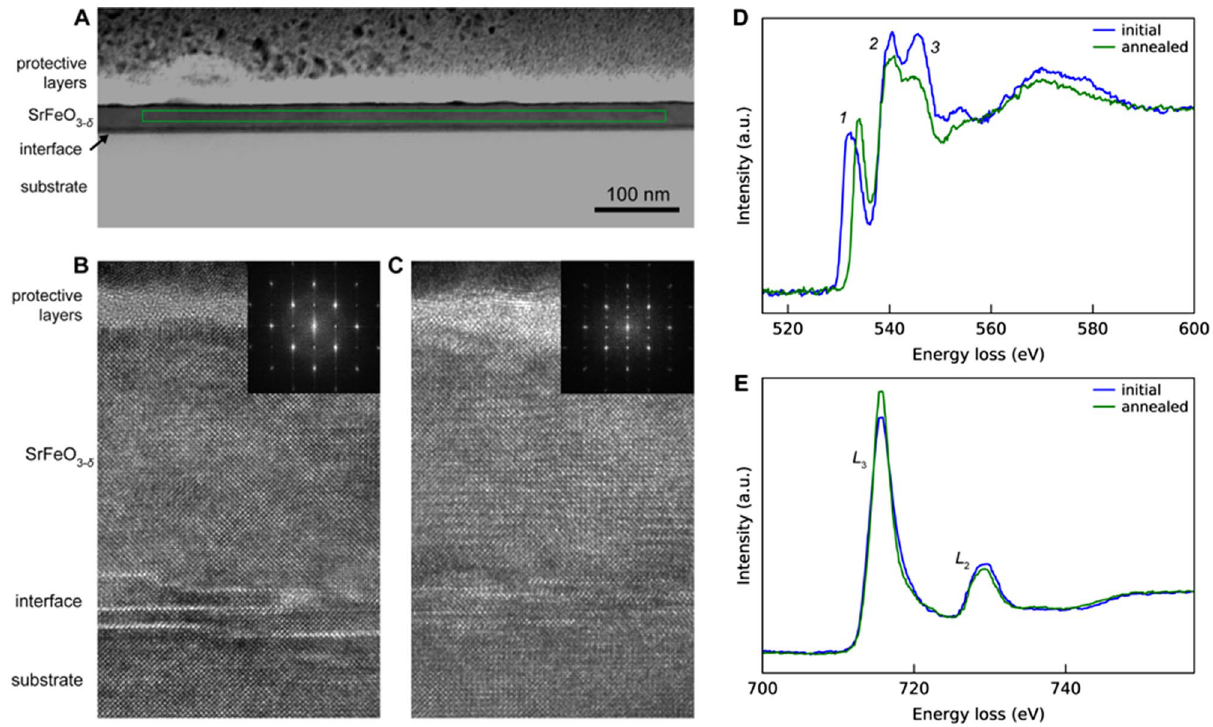
Figure 1. ( A ) STEM ADF of the SrFeO 3 − δ film. The green box shows the location of one SI. ( B , C ) are HRTEM images of the SrFeO 3 − δ before and after the ex situ anneal, respectively. The insets show Fourier transforms (FT) of the SrFeO 3 − δ layer, excluding the defective interfacial region. To obtain adequate SNR for the FT of the annealed sample, FTs from multiple HRTEM images were summed together. D. and E. are the O K -edge and the Fe L -edge, respectively, comparing the initial and annealed SrFeO 3 − δ . The data was averaged over 10 200 pixels, with a local thickness of 0.7 MFP. A power-law background subtraction was applied to both edges, and the edges were normalized to their post-edge continuum dimensions of 10 638 pixels. Three frames were acquired, and a drift correction was performed between each frame. The SI was vertically aligned within the SrFeO 3 − δ layer to only probe the central region of the film, thereby excluding the defective interfacial layer as well as damage at the top of the film (the green box in Fig. 1A shows one representative SI area). Four multi-frame SIs were acquired in the initial-state. Each SI was shifted laterally along the SFO/LSAT interface, which, owing to the sample geometry and FIB preparation method, resulted in sampling various thicknesses of the SFO film. Based on low-loss EELS measurements, the four SIs covered a continuous thickness range from 0.6 to 1.3 inelastic mean free paths (MFPs). Note that the 4 multi-frame SIs give a total of 12 SIs. The exact same procedure was repeated after annealing the sample ex situ. Various irregularities in the protective layers above the SrFeO 3 − δ film were used to correctly position the annealed-state SIs with the corresponding initial-state SIs. While the spectral differences associated with the SrFeO 3 to SrFeO 2.5 transition appear obvious in the data shown in Fig. 1, we note three experimental difficulties which make practical classification of spectra a challeng- ing task. First, the SNR of spectra associated with individual pixel elements is extremely low. For each individual spectra, the average number of electron counts per channel at the O K -edge is ≈ 15 (for a local thickness of 0.8 MFP), which gives a shot noise limited SNR of sqr(N) = 3.8. This low SNR is shown in Fig. 2A. Secondly, given the large range of sample thicknesses, plural scattering leads to significant spectral changes as a function of thickness.